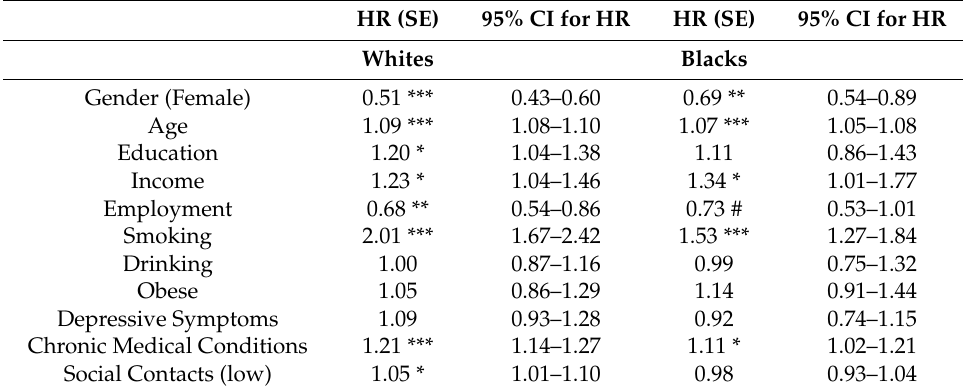
Table 3. Association between baseline social engagement and all-cause mortality stratified by